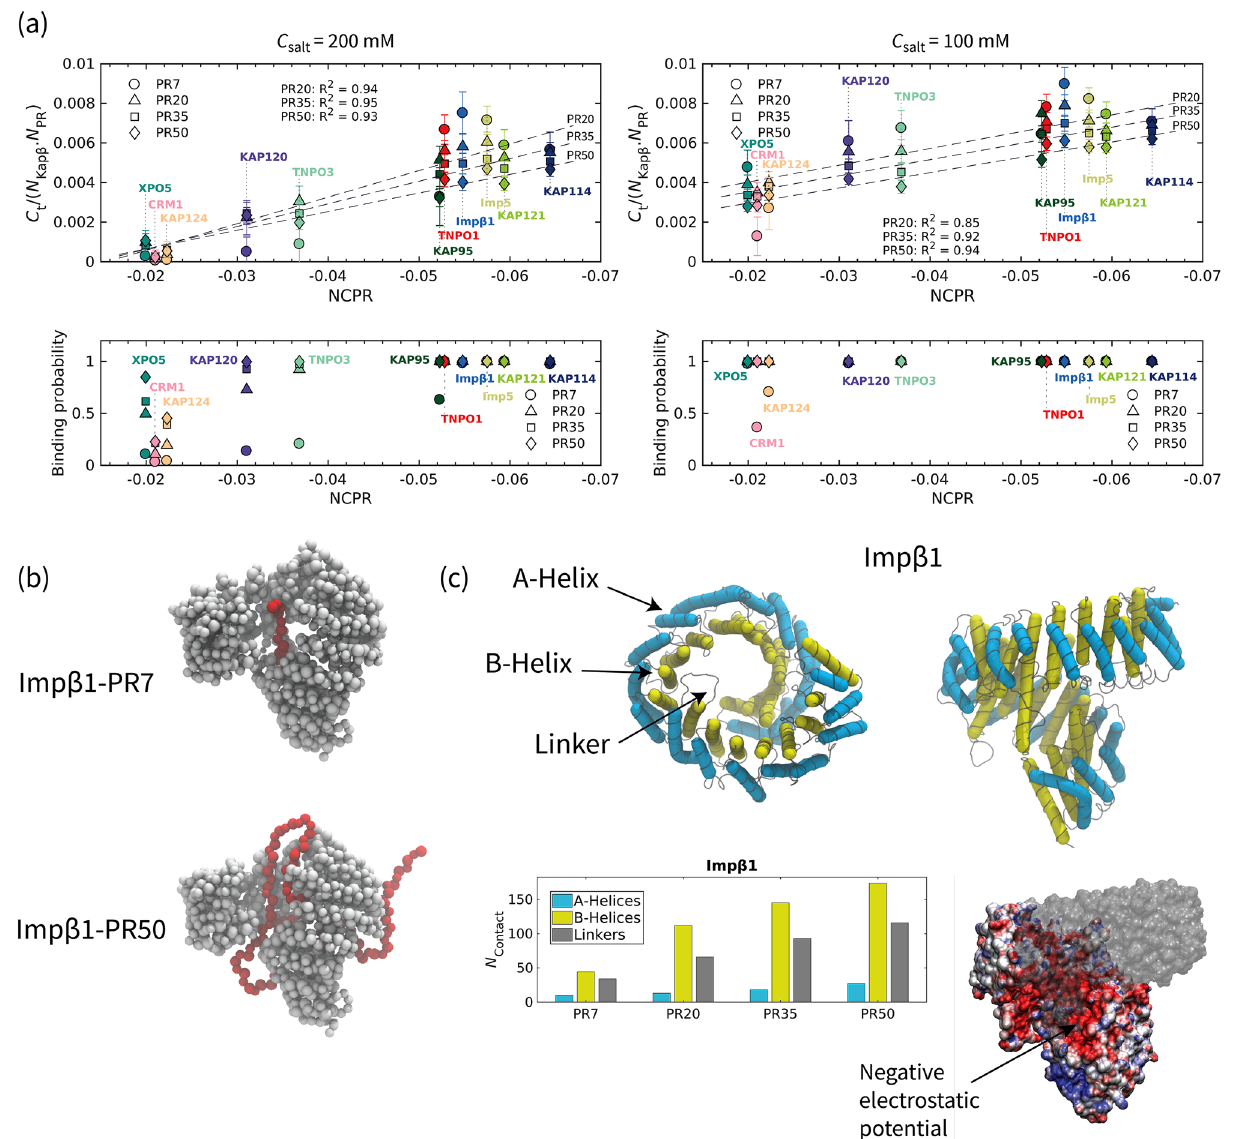
Figure 2. Salt concentration and poly-PR length affect the poly-PR–Kapβ binding behavior. ( a ) Normalized time-average number of contacts C t , and binding probability P b for the interaction between poly-PR with 7, 20, 35 and 50 repeat units and Kapβs at monovalent salt concentrations of C salt = 200 mM (left panel) and C = 100 mM (right panel). A linear correlation can be seen between the normalized C t and the negative salt NCPR of Kapβs for poly-PR with number of repeat units ≥ 20. The dashed lines show linear fits for different lengths of poly-PR. The error bars are half of the standard deviation. The data for PR50 interaction with KAP120 and KAP114 were taken from 39 . ( b ) Sample snapshots showing the binding of PR7 and PR50 to Impβ1. In each snapshot poly-PR is depicted in red and Impβ1 is depicted in light grey. ( c ) (Top panels) The structure of Impβ1 shown from a top view (left) along the superhelical axis and a side view (right). A- and B-helices of Impβ1 are highlighted with light blue and yellow tubes, respectively, using the Bendix plugin in VMD. The linkers that connect the A- and B-helices are shown in light grey. A-helices constitute the inner surface and B-helices constitute the other surface of Impβ1. See Table S4 for snapshots of the other Kapβs used in this study. (Bottom panels) The number of residues in each region of Impβ1 that make contact with poly-PR ( N contact ) at C salt = 100 plotted for PR7, PR20, PR35 and PR50 (for details see Sect. 2 of the SI). The results for other Kapβs are shown in Fig. S5. Poly-PR tend to make more contacts with the inner surface of Impβ1, i.e. B-helices. The electrostatic potential of Impβ1 shows negatively-charged regions (shown with an arrow) on the inner surface of Impβ1. The electrostatic surface potentials are obtained using PDB2PQR 50 and plotted using the Surf representation in VMD on a red-white-blue map. Positive and negative surface potentials are denoted by blue and red, respectively. For better visualization, part of the electrostatic potential surface is depicted using a transparent surface. Electrostatic potentials for the other Kapβs are presented in Table